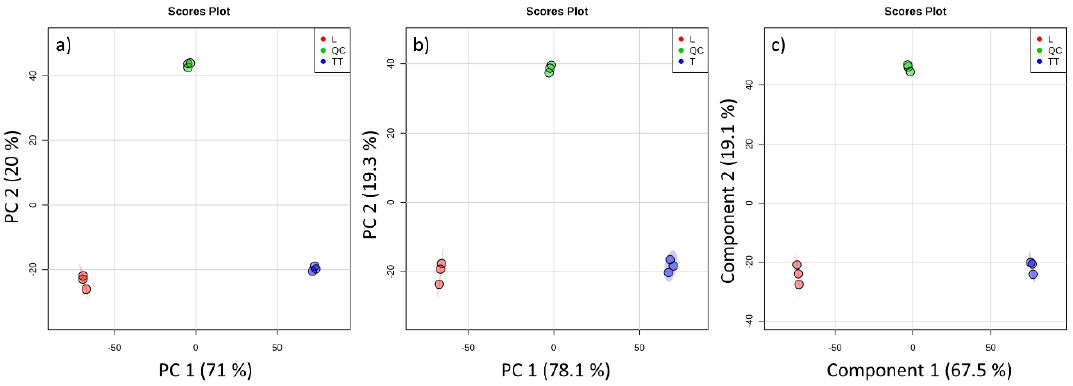
Figure 3. A comparison to feature selection protocols in group-based analysis. ( a ) PCA of analytes selected with ANOVA p < 0.05; ( b ) PCA of analytes selected with a Fisher Ratio p < 0.05; ( c ) Partial least squares-discriminant analysis (PLS-DA).